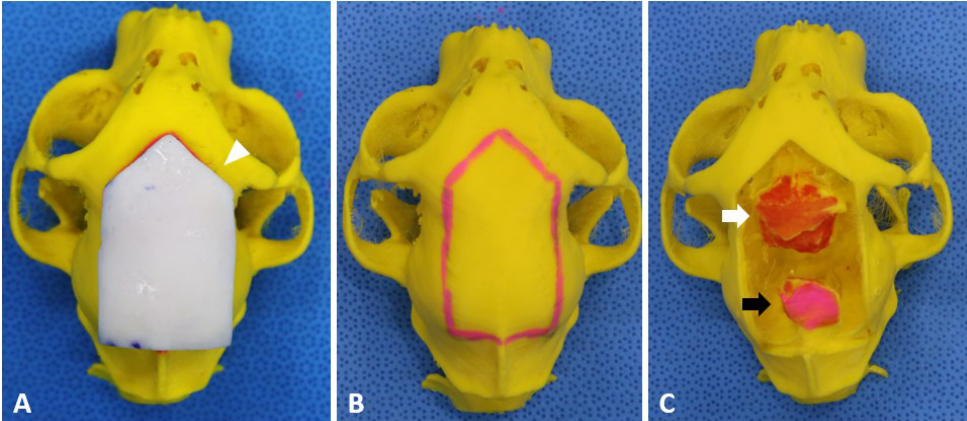
Figure 2. Preoperatively designed three-dimensional (3D) guide and models for rehearsal surgery and intraoperative craniotomy. ( A ) 3D-printed guide (arrowhead) is produced to determine the extended rostrotentorial craniotomy line by fitting on to the skull. ( B ) The 3D model represents the craniotomy line (red line). ( C ) 3D model represents the location of meningiomas in the frontal (white arrow) and occipital lobes (black